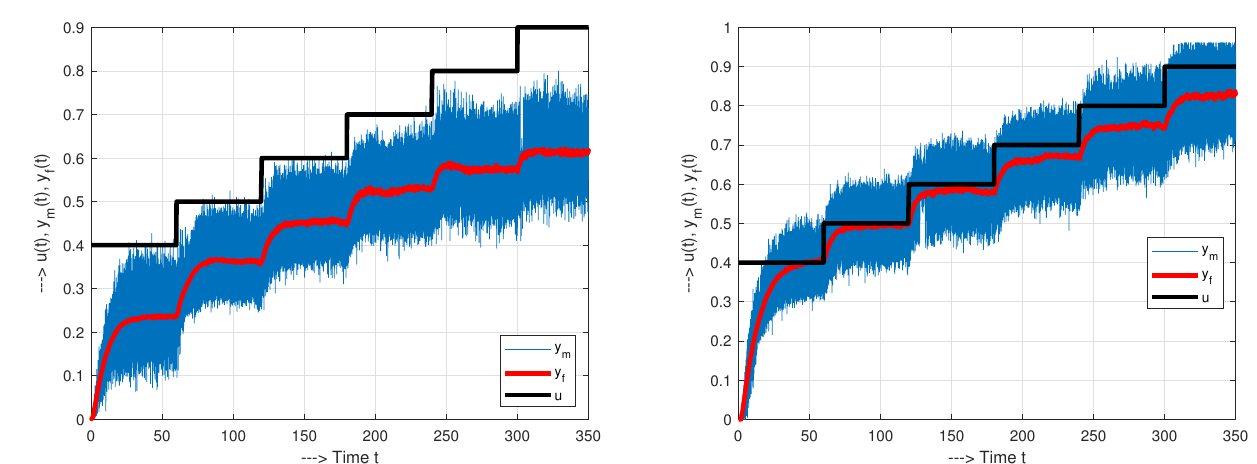
Figure 2. IOSSCHs of a mechatronic system with a measured output y m , a filtered output y f and a process input pulse-width u measured before and after maintenance (bearing